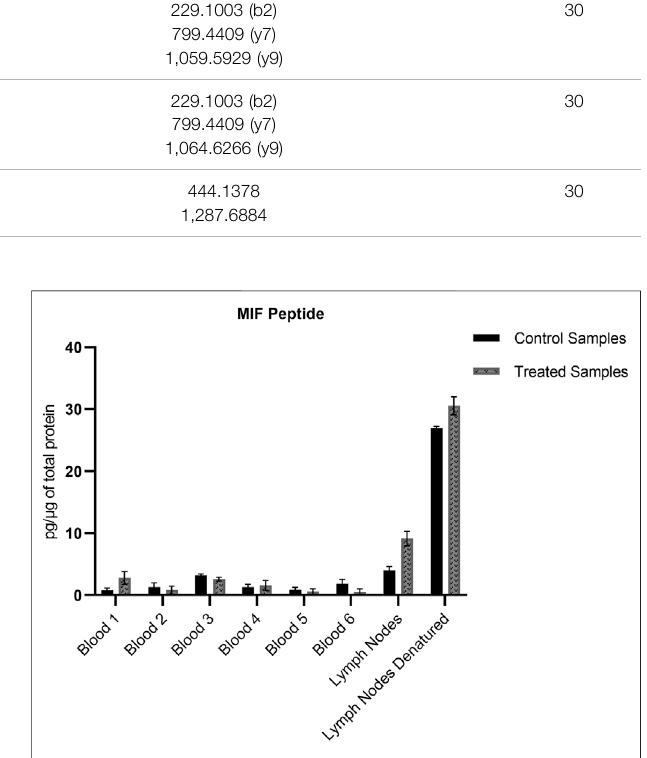
TABLE 2 | Speci fi c parameters used in the quanti fi cation method for each speci fi c compound, including exact mass of the parent ion, collision energy, fragments used for quanti fi cation. Compound